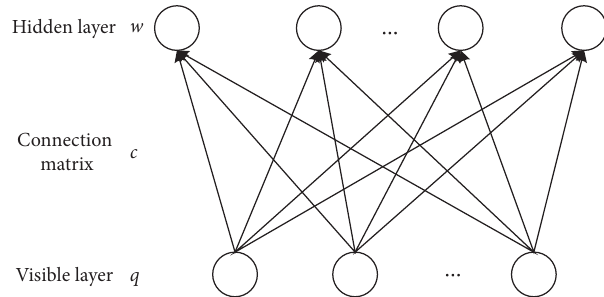
Figure 1: RBM network structure